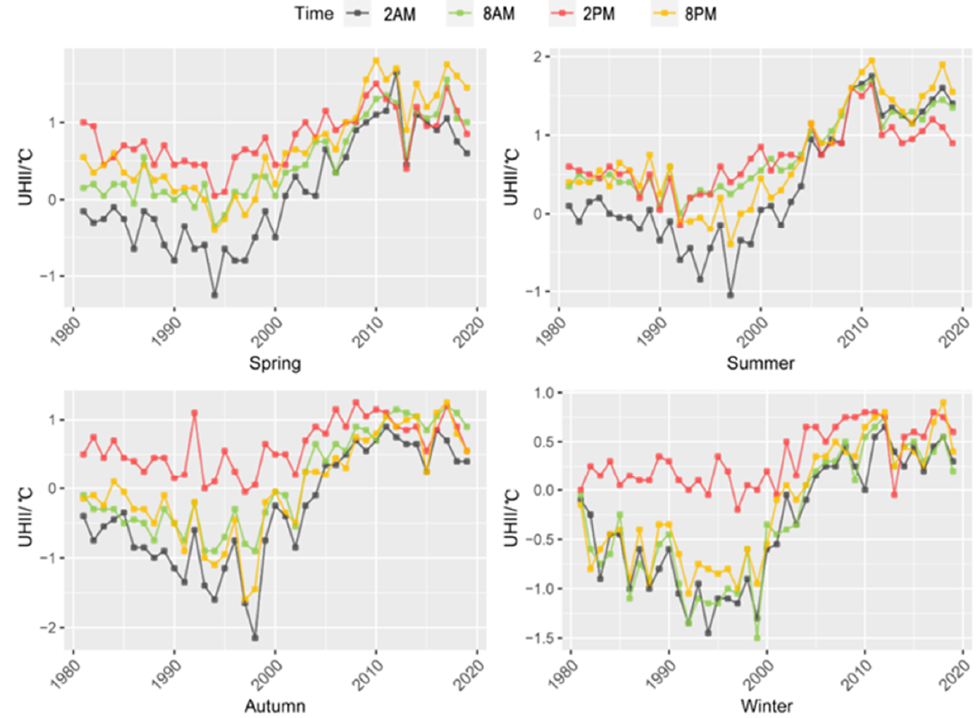
Figure 5. Characteristics of four-season hourly mean variations in atmospheric UHI intensity (1981– 2019).